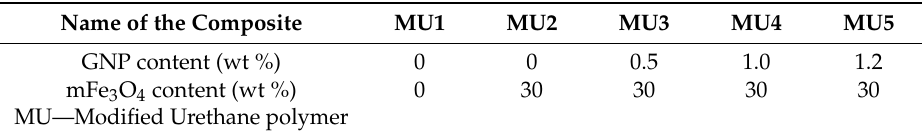
Table 1. The composition of the